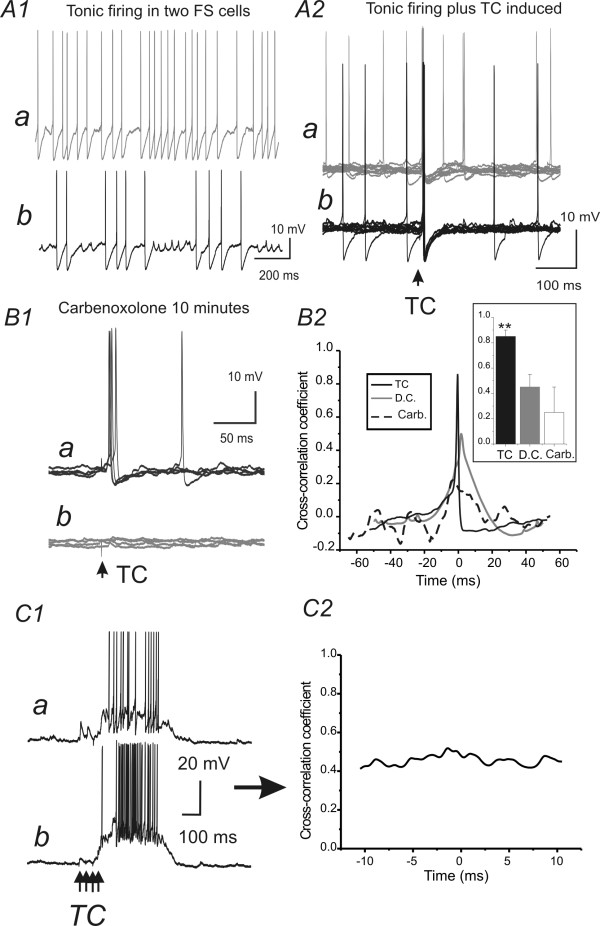
Effects of EPJPs in synchronizing direct-current (DC) and TC-induced spikes in FS pairs of barrel cortex layer IV. A) Tonic-spikes without (A1) or with TC stimulus (A2) in FS pairs. B1) TC- spikes in the presence of carbenoxolone (Carb.,) in the same FS pairs. B2) Cross-correlation analysis of the response of A1 (gray), A2 (black solid line) and B1 (black dotted line). Inset: comparison of the degree of synchronization induced by TC with GJ coupling (filled black bar), D.C. with GJ coupling (filled gray bar) and TC without GJ coupling (open bar), respectively. **: p < 0.01 vs. D.C. and carbenoxolone groups, respectively, n = 5. C1) High frequency TC stimulus (4 shock@25 Hz) induced responses in the same two FS cells. Note that the TC stimuli induced an "upstate" in which the membrane potentials of the two FS cells were very close to firing threshold. C2) Cross-correlation analysis of the response traces of C1.